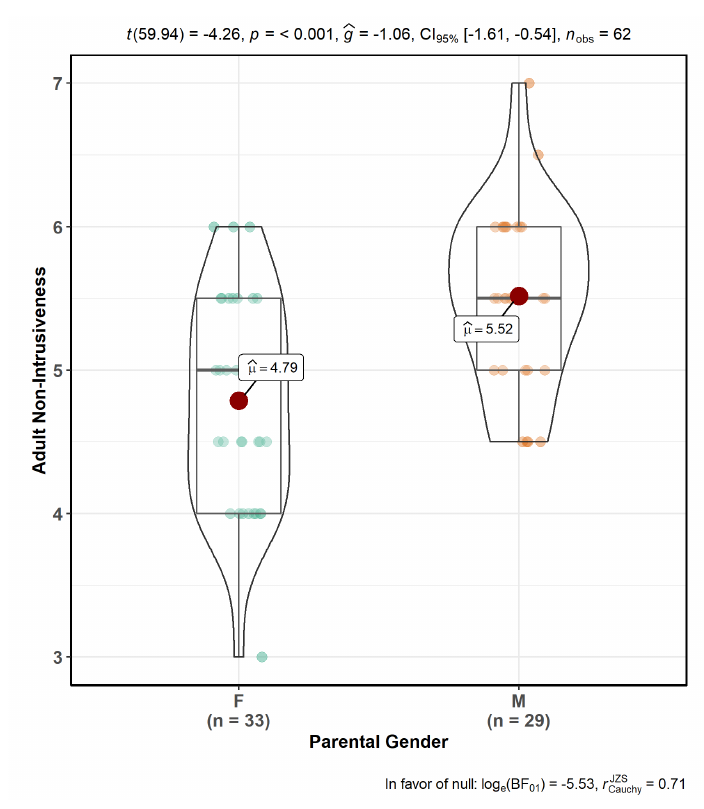
Figure 1. Violin plot which depicts fathers’ greater non-intrusiveness compared to mothers’ during play